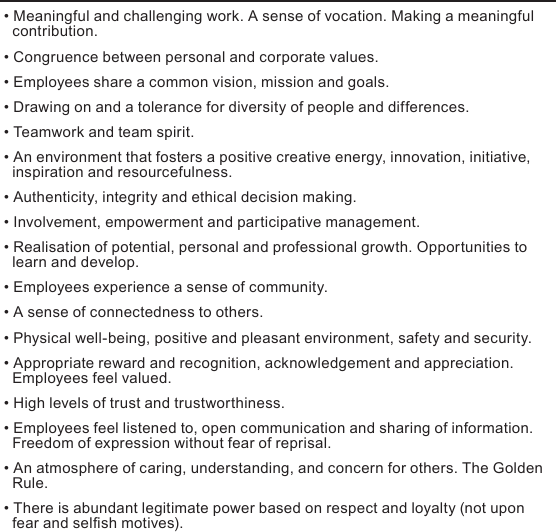
TABLE 5 Characteristics of spirituality at work measured in this